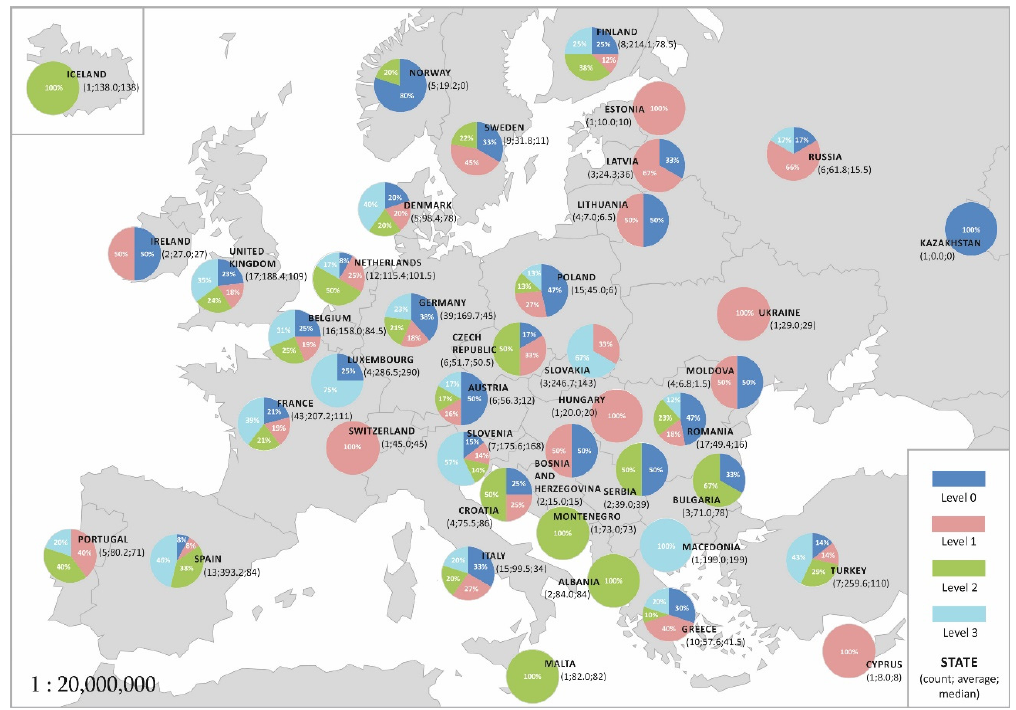
Figure 1. Results of statistical analysis for the number of meetings in the studied promotional events, depending on the country in which the event took place. Source: own study.